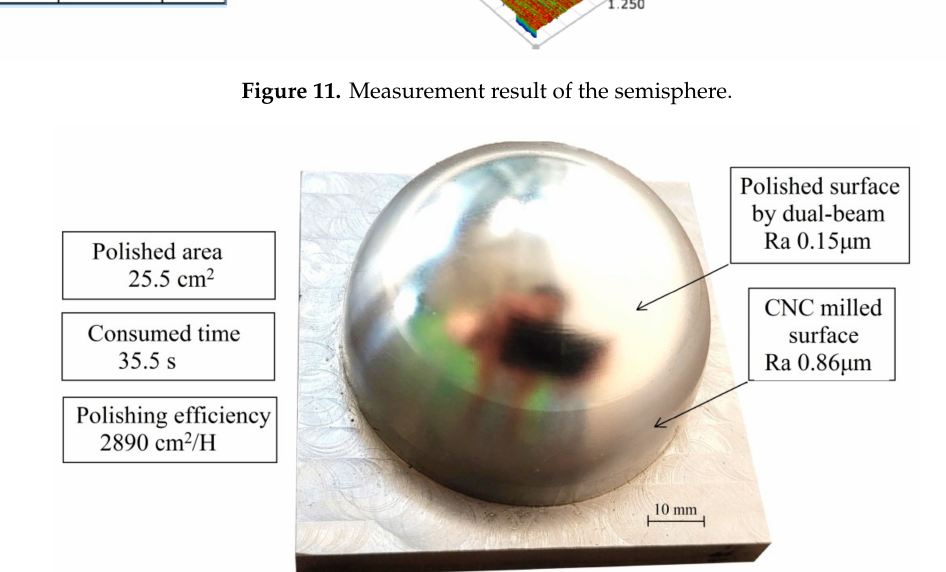
Figure 12. Polished semisphere by